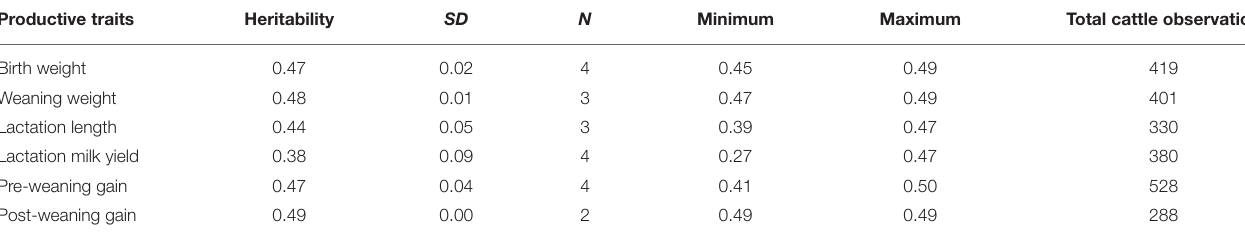
TABLE 2 | Heritability estimates of some productive traits of Red Chittagong cattle.